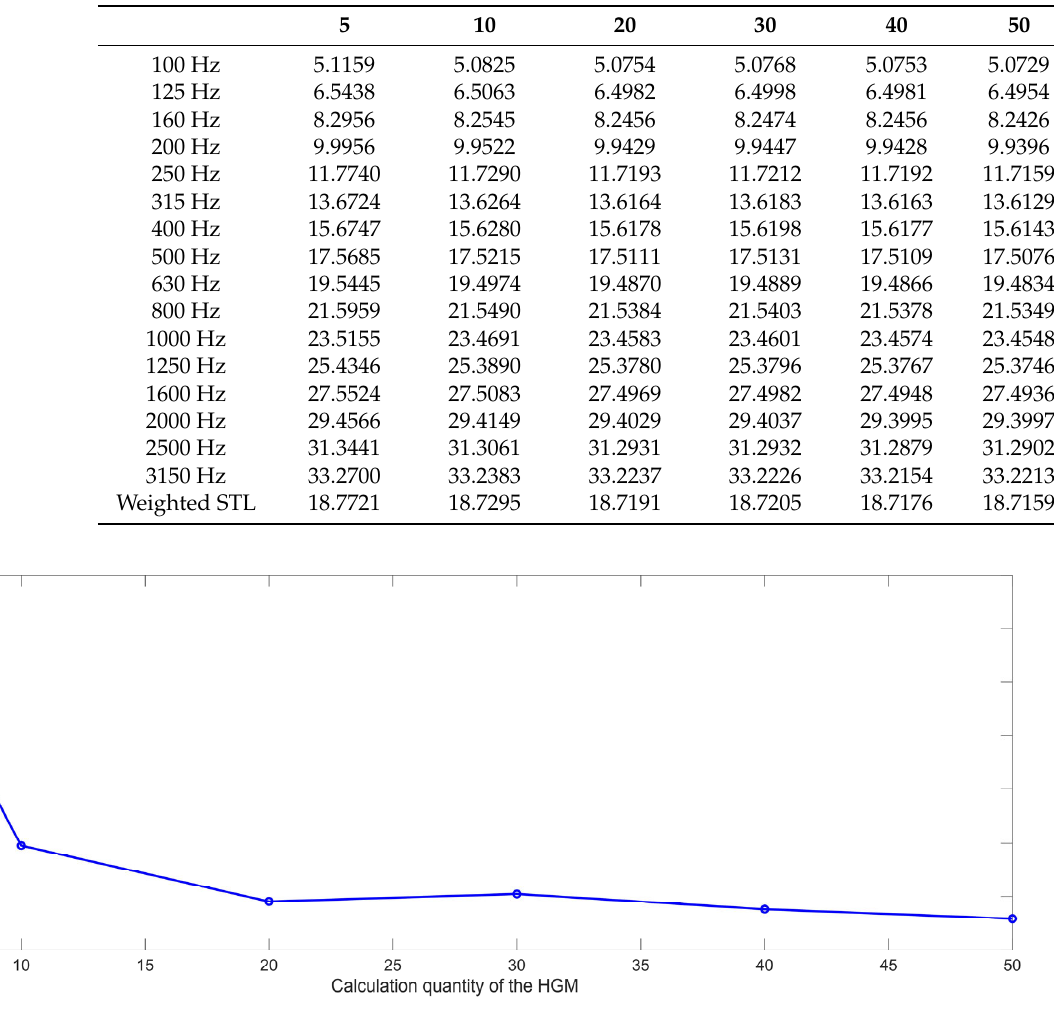
Figure 5. The weighted STL of composite rubber reinforced with HGM for the various calculation quantity of the HGM.